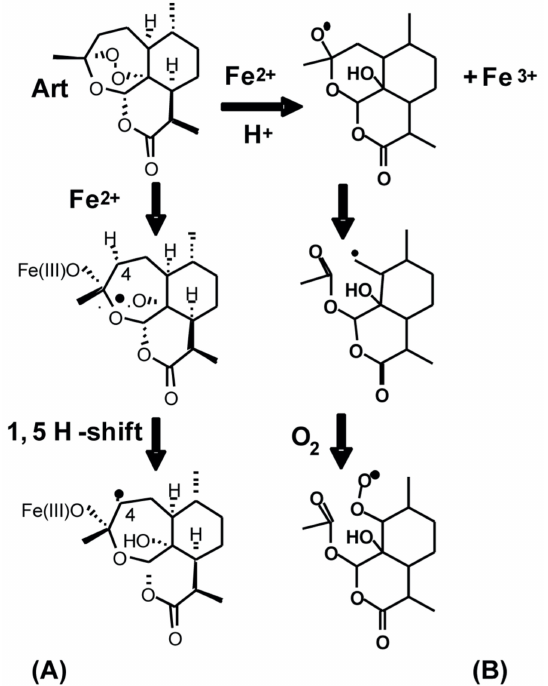
Figure 10. Pathways of artemisinin ( A ) carbon and ( B ) oxygen centered radical formation in cell-free